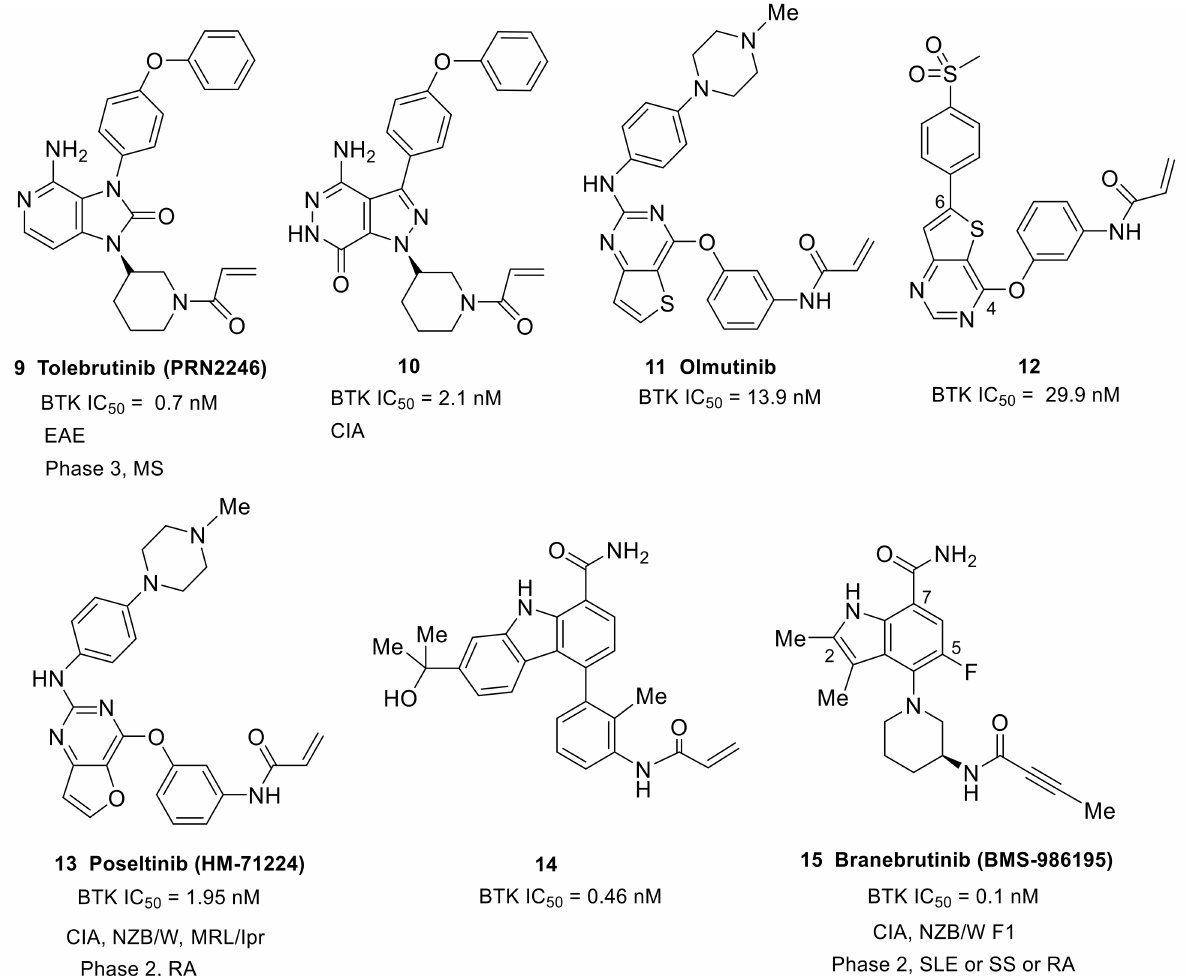
Figure 6. The representative structures of covalent irreversible BTK inhibitors with fused bicyclic heterocycle scaffolds and their progress in the treatment of autoimmune and inflammatory diseases. EAE, experimental autoimmune encephalomyeli- tis; MS, multiple sclerosis; SLE, systemic lupus